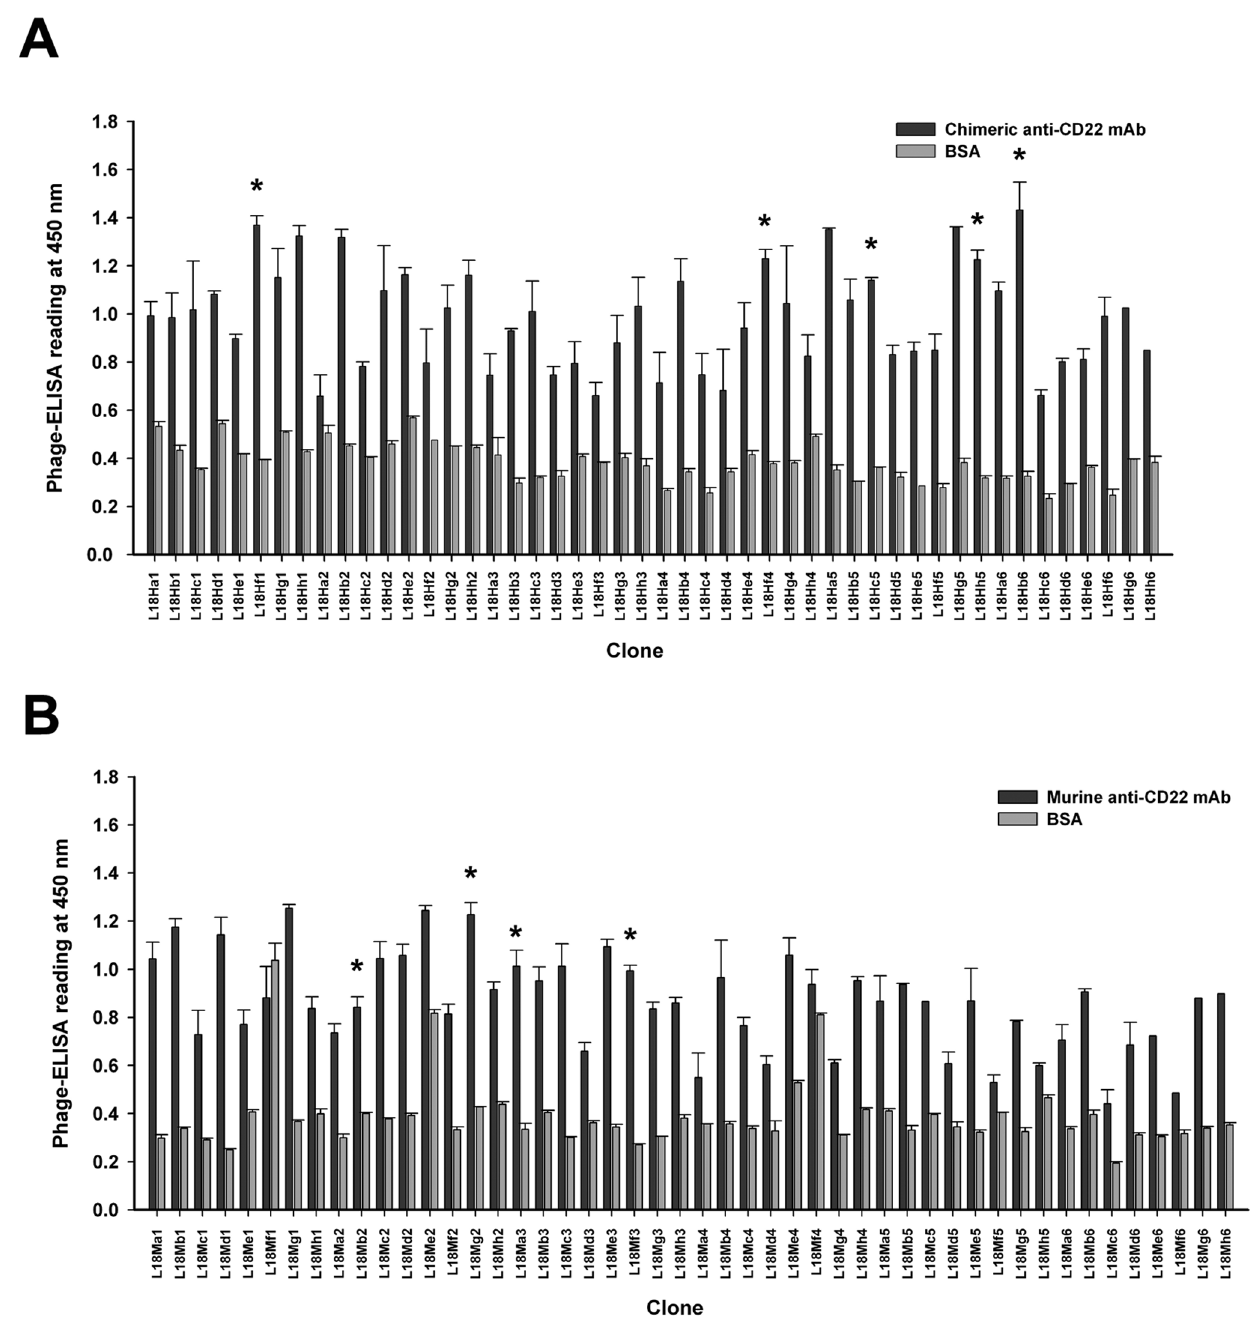
Figure 2. PhageELISA screening of phage clones for reactivity towards idiotype anti-CD22 monoclonal antibody. Individual colonies from the fourth round of biopanning were evaluated in 96-well ELISA plates coated with 0.1 m g/well of MAb or BSA (negative control). Freshly prepared phages were incubated for 1 h against chimeric anti-CD22 MAb (A) or murine anti-CD22 MAb (B). Bound phages were detected with HRP- conjugated anti-M13 as described in Methods. Data shown are means 6 SEM of duplicates. The asterisk (*) denotes phage clones that were selected for further evaluation.